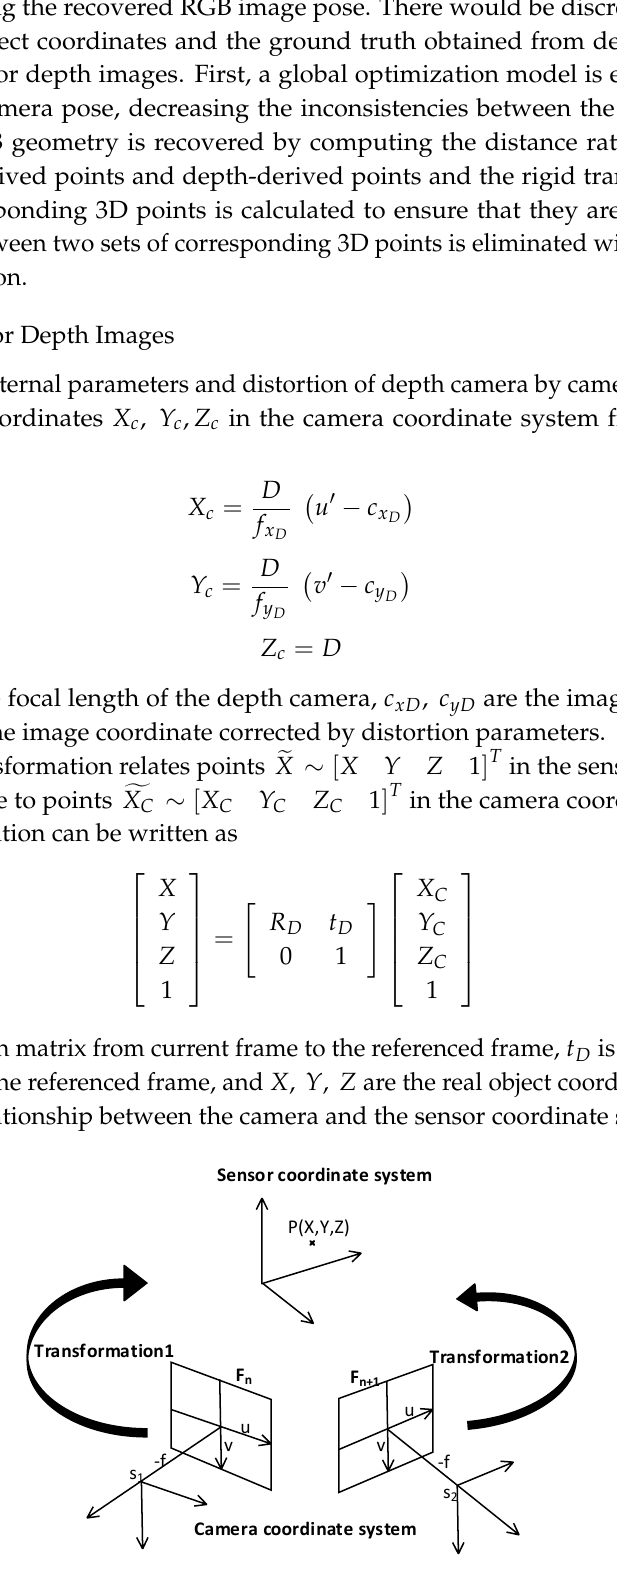
Figure 4. Relationship between the camera and the sensor coordinate systems.